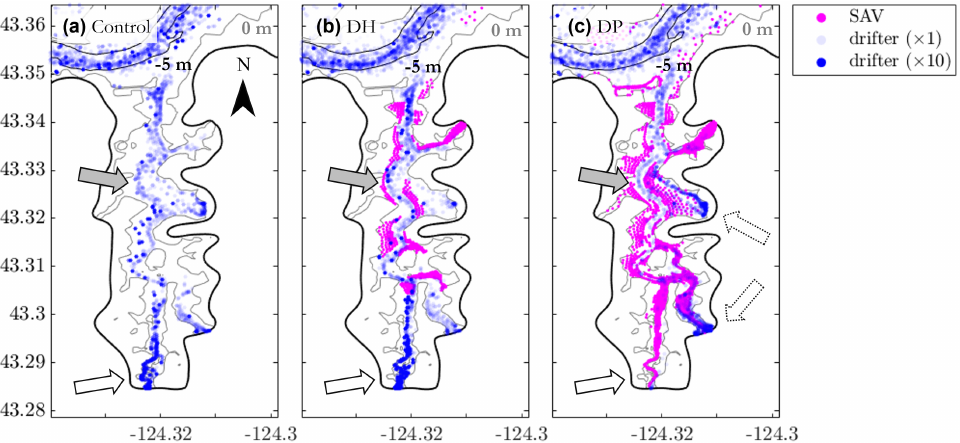
Figure 6. Discretized numerical drifter pathlines (blue transparent) for simulations in which SAV is parameterized as ( a ) absent for the Control, ( b ) DH, and ( c ) DP. Location of SAV computational nodes shown in magenta. Elevation contours correspond to 0 m (thing grey line) and − 5 m (thin black line). Arrows used as reference points in text. Bold black line indicates model boundary. Horizontal and vertical axes correspond to longitude and latitude